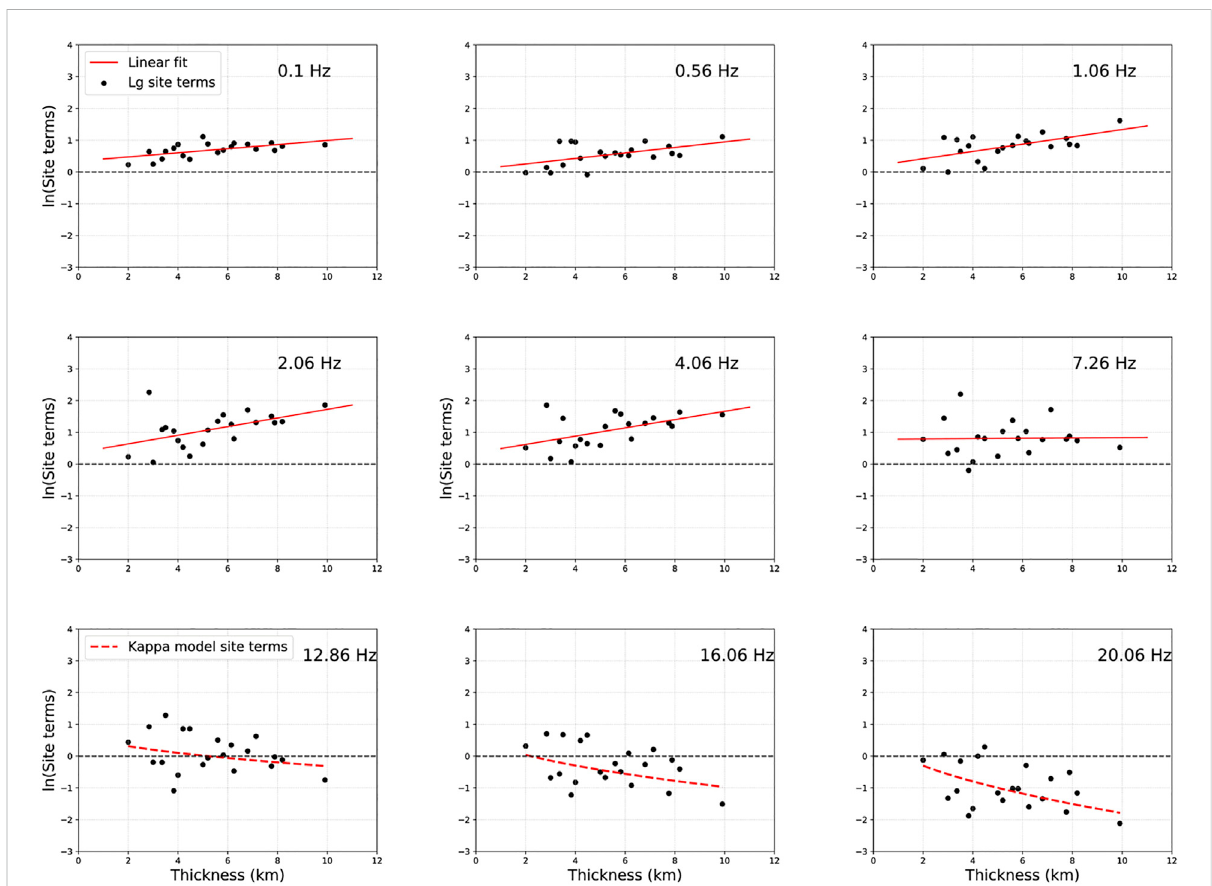
FIGURE 8 Naturallogarithmsofsiteterms(dots)estimatedfromlinearregressionofEq.8usingLgwavesforstationsintheSichuanBasinversussediment thickness over frequency range 0.1 – 7.26 Hz. The solid lines indicate linear regression results of the Lg site termswith respect to sediment thickness. The dashed lines show estimates calculated using Eq. 6 and the κ 0 model represented by Eq. 10.